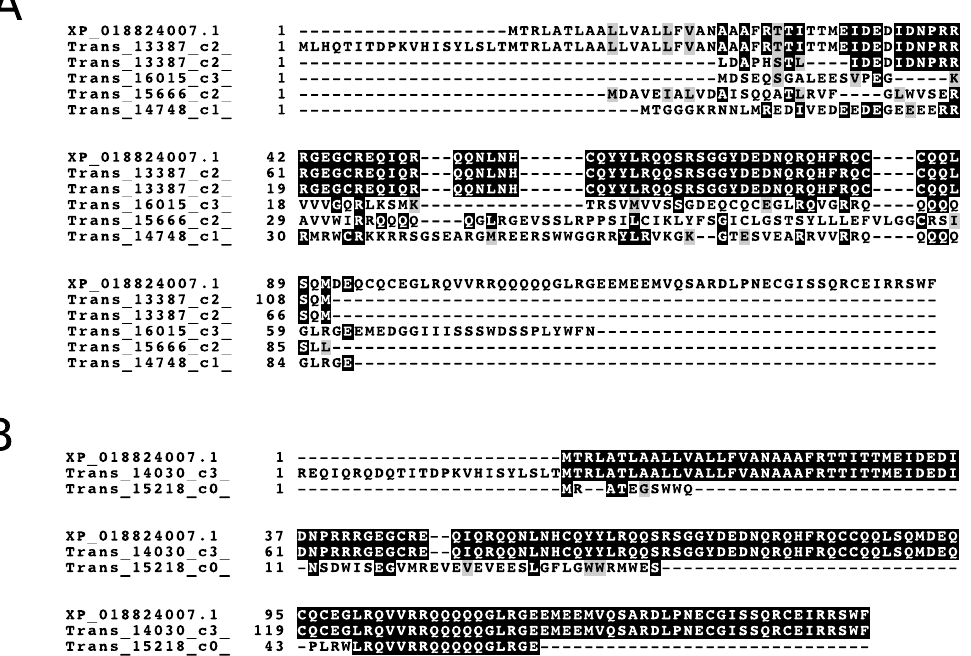
Figure 4. Alignment of sequences from a cluster of related sulfur-rich seed storage sequences from a parsimonious comparison ( A ). Comparison of the NCBI proteome (XP 018824007.1) and the transcriptome assembled under published conditions. ( B ). Comparison of the NCBI proteome and the improved transcriptome assembled using Rcorrector and max_pct_stdev = 100.